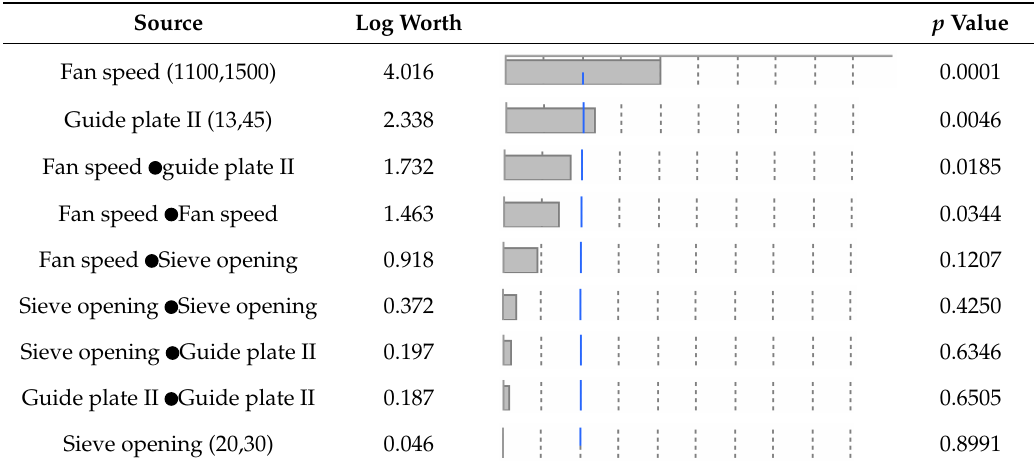
Table 4. Surface response experiment results analysis for grain sieve